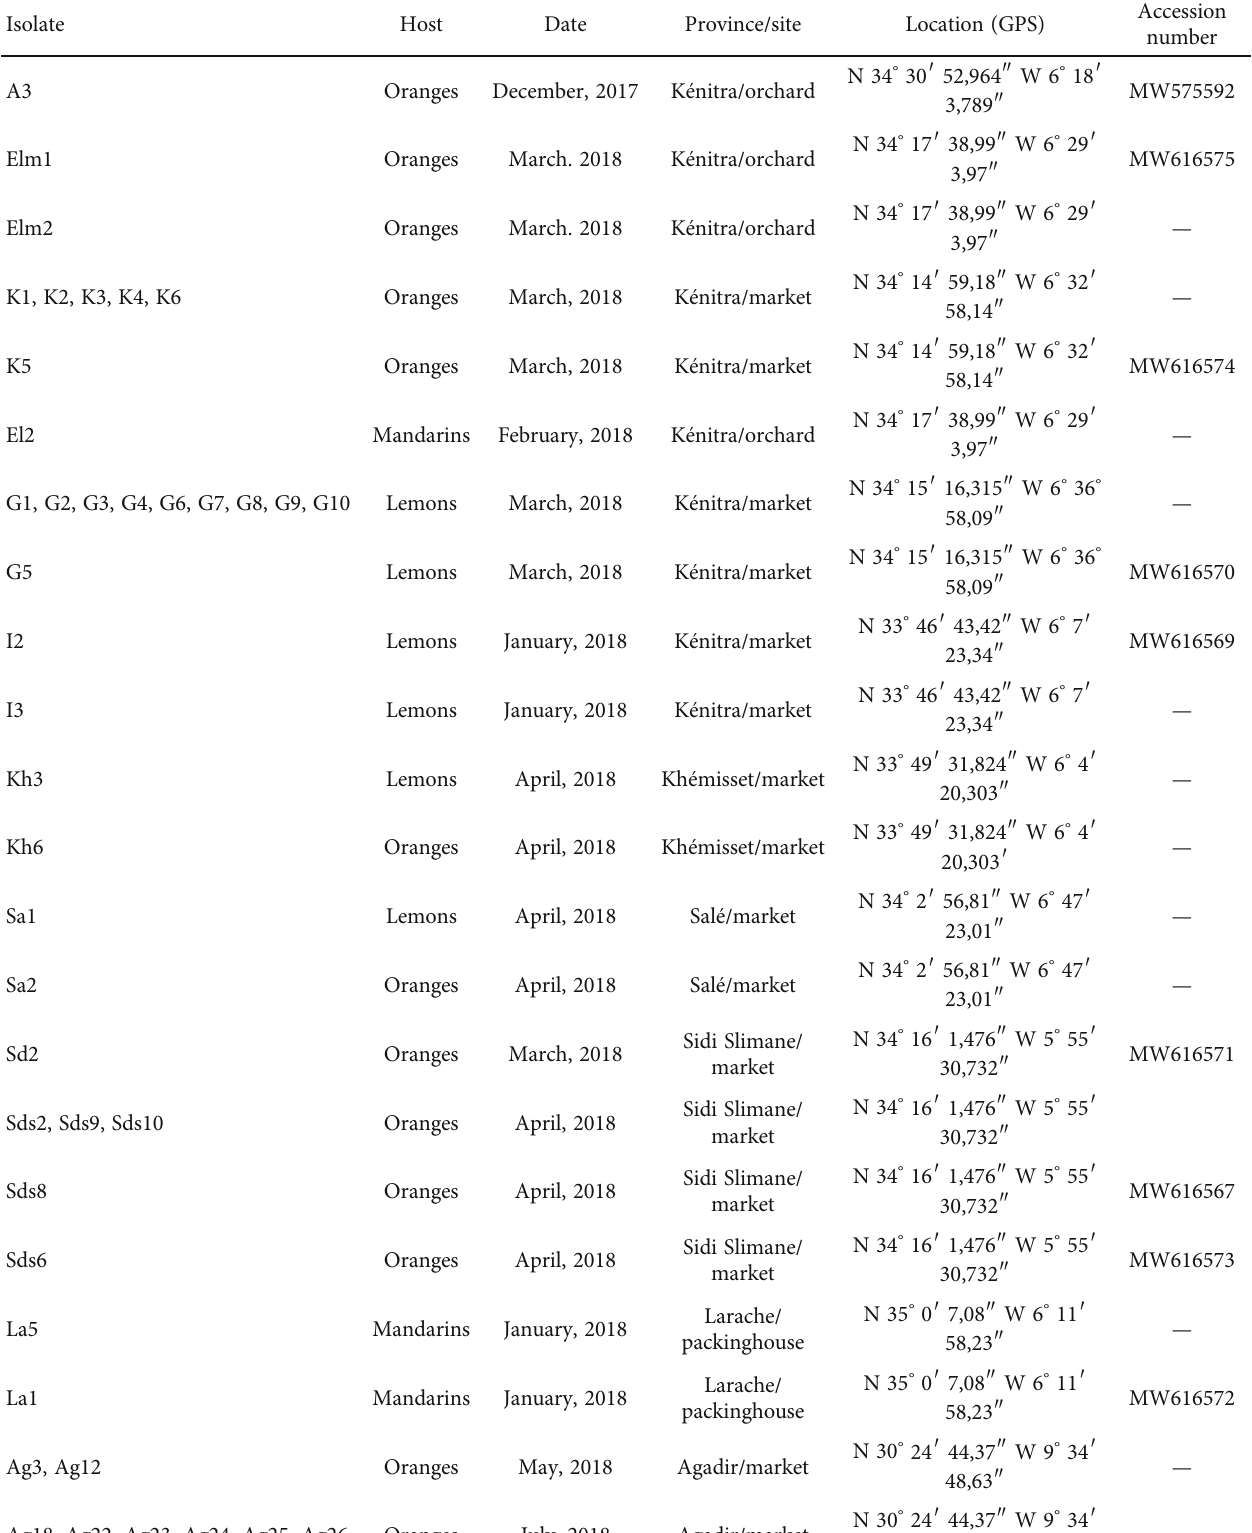
Table 1: Isolates of Alternaria spp. obtained from citrus fruits during 2017-2018.